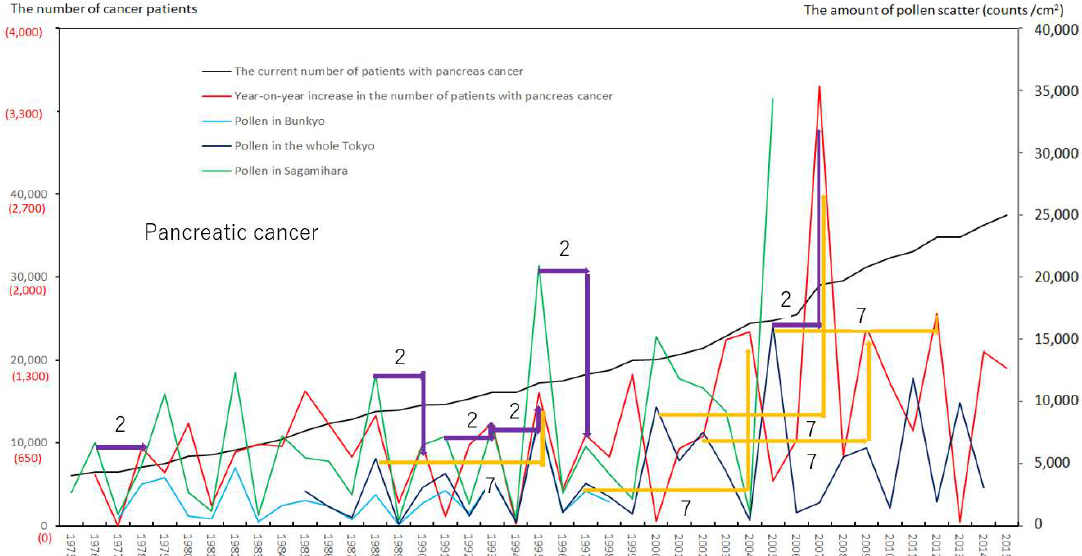
Figure 7. The current number of Japanese males and females (presently registered patients) registered for pancreatic cancer at the year diagnosed, its year-on-year increase (newly registered patients), and the amount of air borne pollen scatter in 3 areas during the period from 1975 to 2015. The line graphs for males and females with pancreas cancer representing numbers of presently and newly registered patients in each year, as well as the amount of pollen scattered during the period from 1975 to 2015. Violet or orange arrows indicate phasic increments of newly registered patients occurring two or seven years after phasic increments of airborne pollen scatter, respectively.